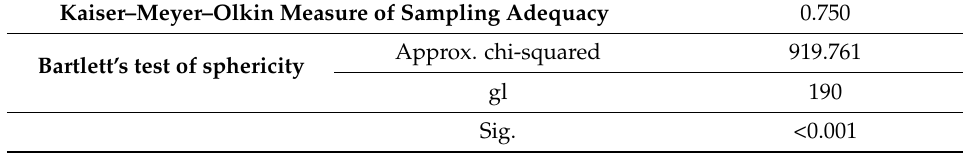
Table 2. KMO test and Barlett ´ s sphericity.